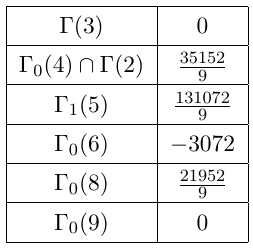
Table 8. The j -invariants that correspond to the six index-12 Belyi maps.